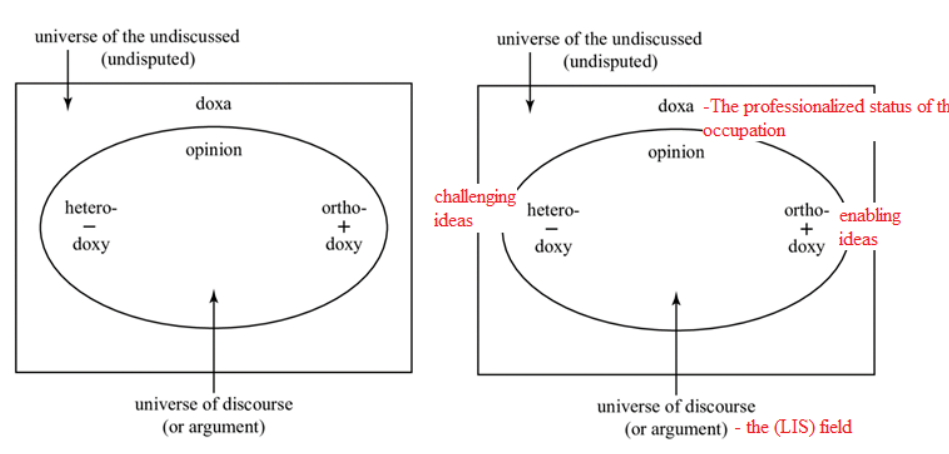
Figure 1: Field of opinion and doxa Figure A : Figure